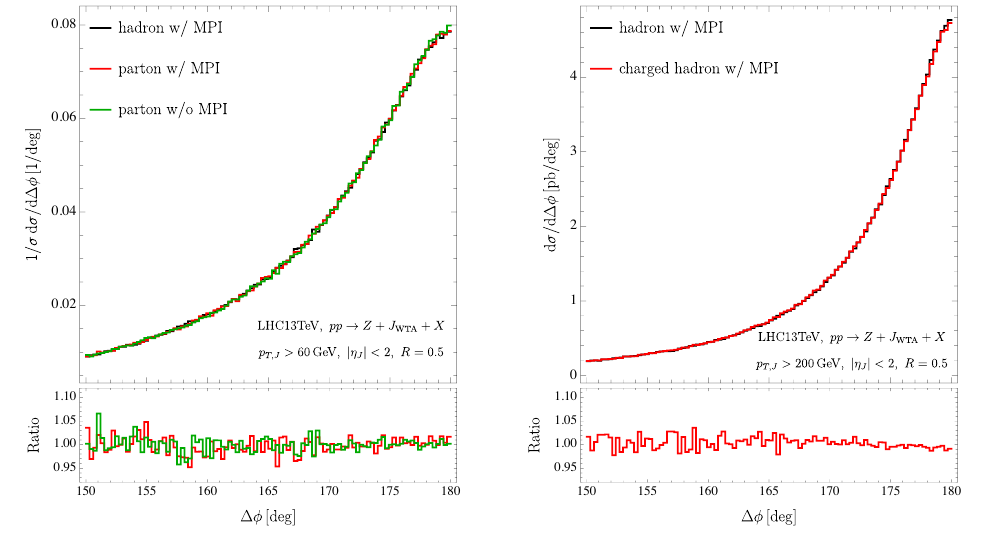
Figure 10. Normalized ∆ φ distribution for Z +jet in Pythia . Left: at the parton level with or without MPI contributions, as well as at the hadron level (including MPI). Right: at the hadron level using all or only charged particles for WTA axis definition.